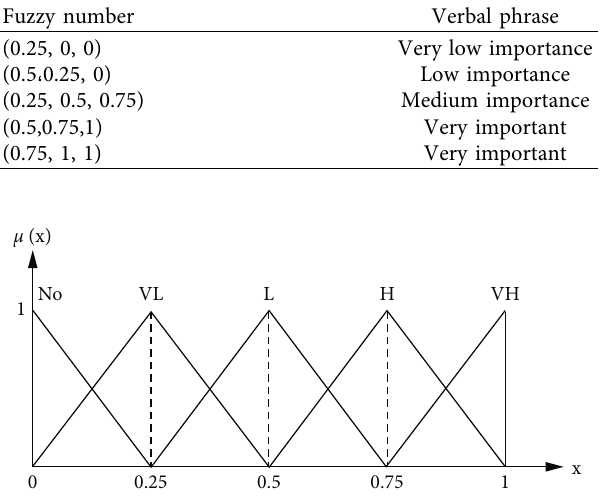
Figure 3: Triangular fuzzy numbers for verbal phrase.